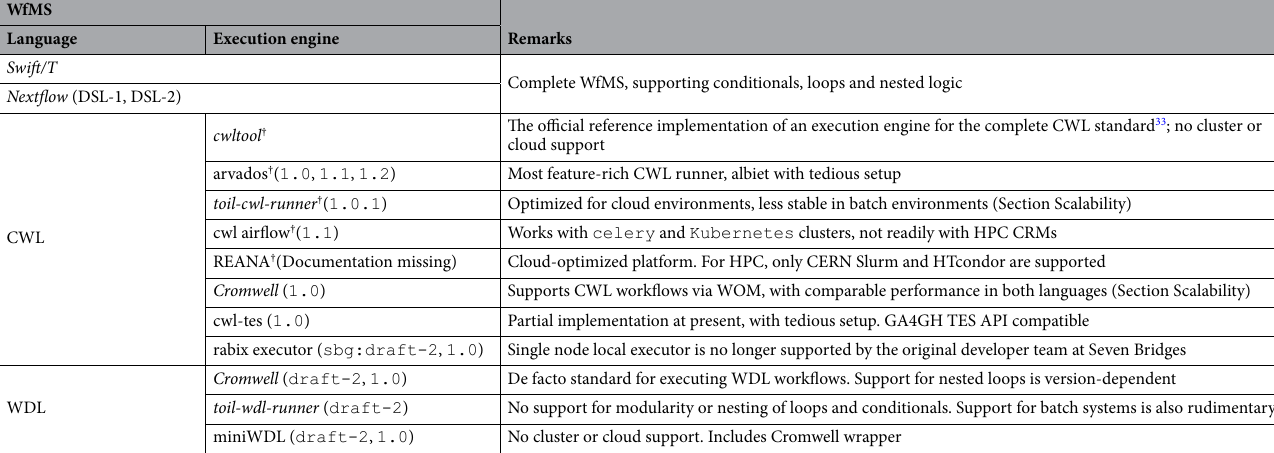
Table 2. Summary of executor-level differences among Swift/T, Nextflow, CWL and WDL. Any given feature of a workflow language can be assumed supported by the executor, unless we note otherwise. Supported language versions are in parentheses for each executor. Italics indicates engines we thoroughly examined. † These are listed as production-ready engines in the official CWL website in July 2021. The rest are listed as partial